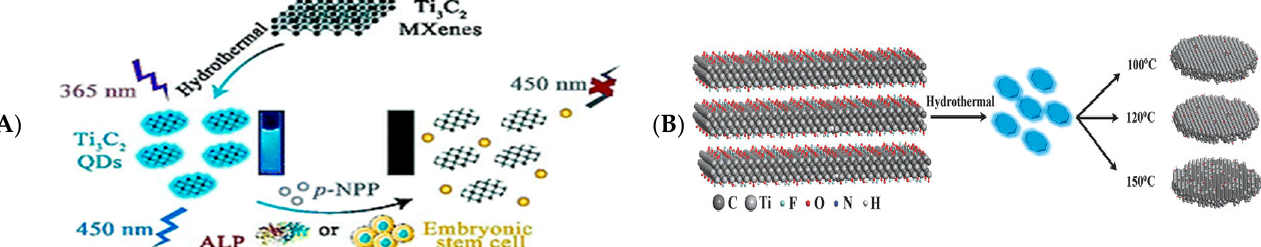
Figure 10. ( A ) Schematic diagram of fluorescence assay of alkaline phosphatase activity of MQDs. Reprinted with permission from Ref. [102]. Copyright 2018, Royal Society of Chemistry. ( B ) Schematic diagram of hydrothermal preparation of MQDs. Reprinted with permission from Ref. [100]. Copyright 2017, Wiley-VCH.